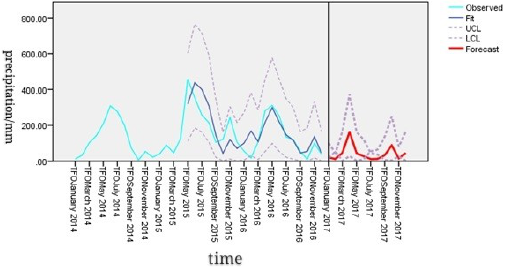
Figure 2. Figure forecast model of average daily precipitation in Guilin from 2014 to 2017